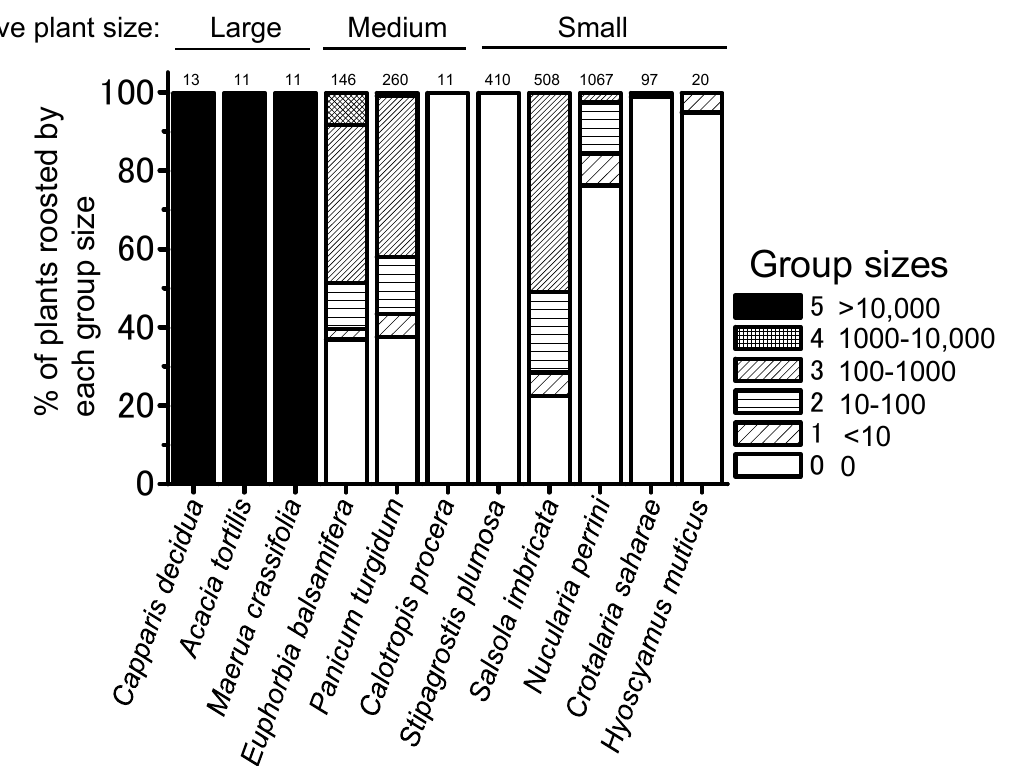
Figure 4. Percentage of plants roosted by each group size of Schistocerca gregaria swarms for the 11 dominant plant species at the four study sites. Numbers above bars indicate sample sizes (numbers of plants observed).